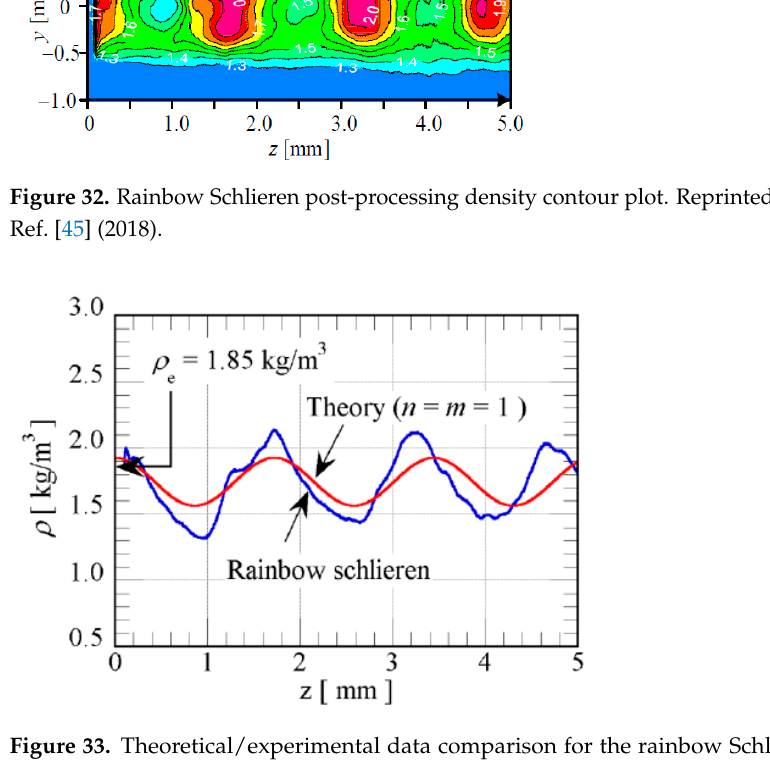
Figure 33. Theoretical/experimental data comparison for the rainbow Schlieren. Reprinted with permission from Ref. [45] (2018).